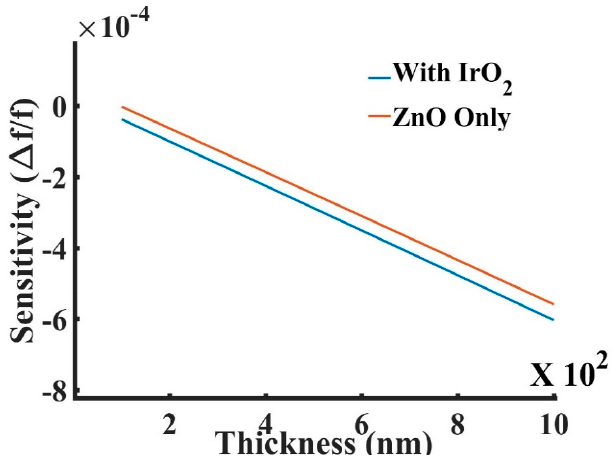
Figure 15. The frequency sensitivity comparison between a SAW-based device with only varying ZnO layer and a device with 50 nm IrO 2 layer on top of the varying ZnO layer.